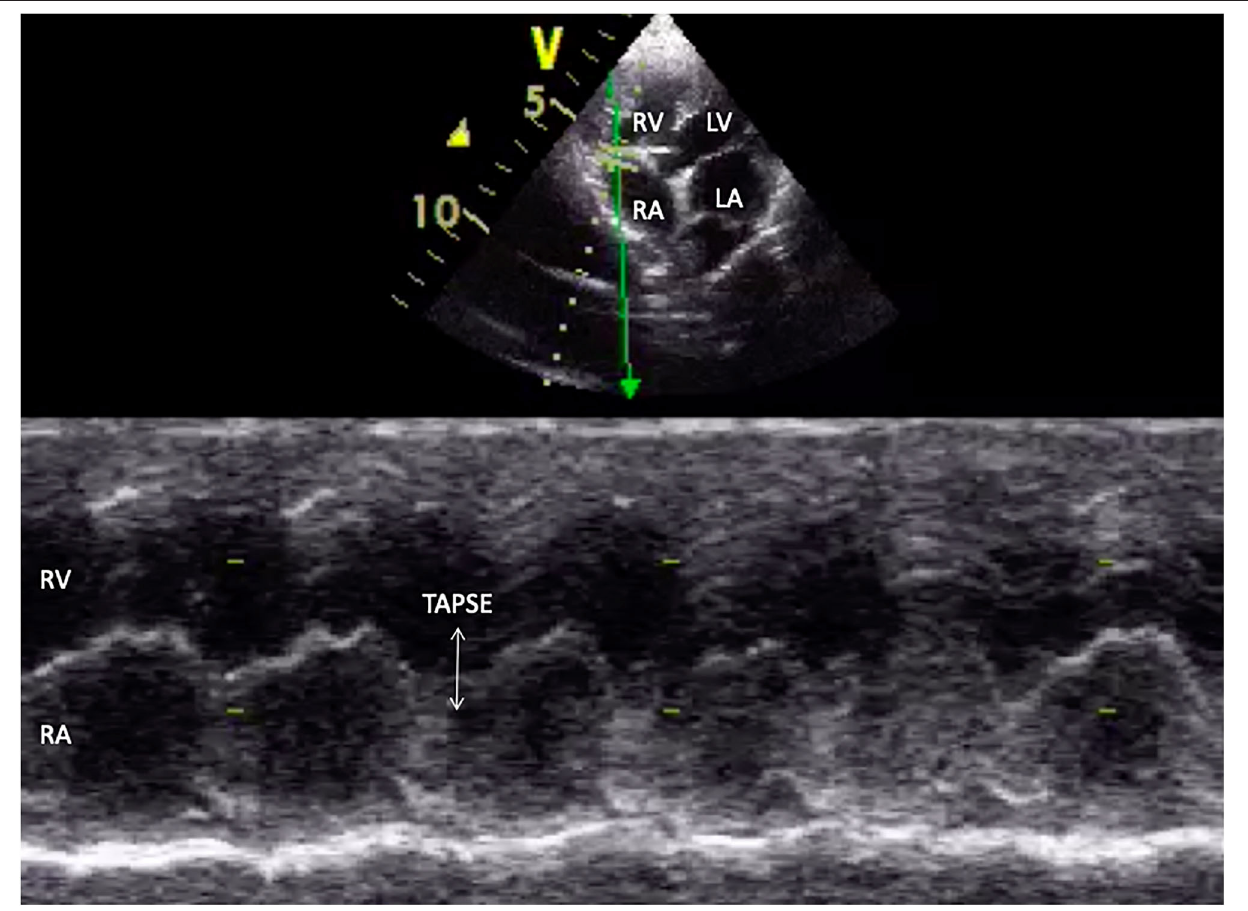
FIGURE 4 | M-mode echocardiographic image of tricuspid annular plane systolic excursion (TAPSE) in appearance (white arrow). RA, right atrium; RV, right ventricle; LV, left ventricle; LA, left